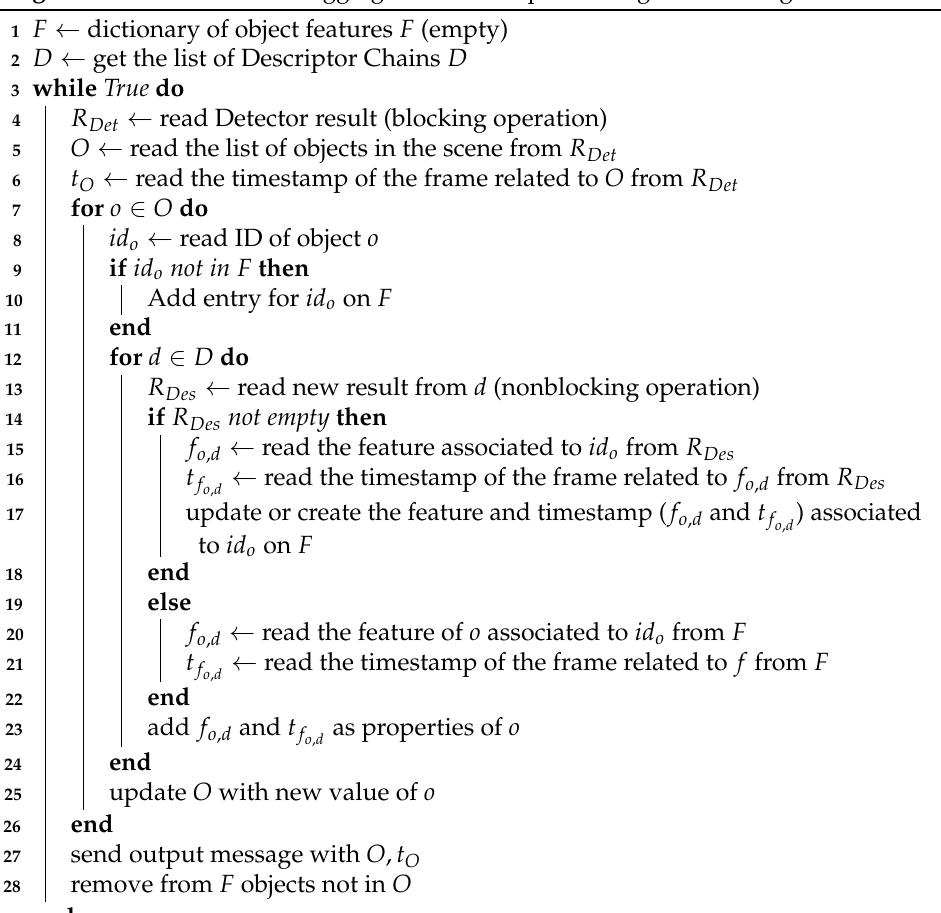
Algorithm 2: Collector data aggregation and output message creation